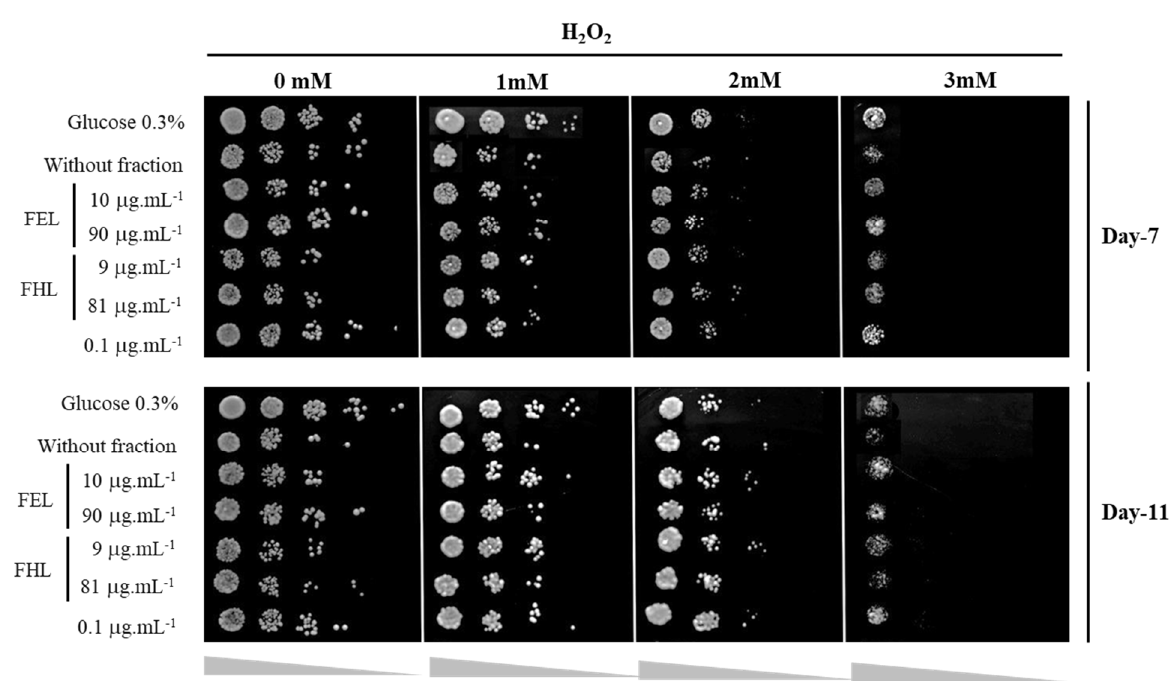
Figure 4. The effect of the treatment of two selected concentrations of each leave fraction on the viability of S. pombe against H 2 O 2 –induced oxidative stress conditions after 7 and 11 days of incubation. FHL: clove leaf n-hexane fraction, FEL: clove leaf ethanol fraction. Yeast grown in low glucose (0.3%) was designed as positive longevity control, while yeast grown in normal YES medium withour fraction was used as negative control. Ascorbic acid was used as a control of antioxidant treatment.